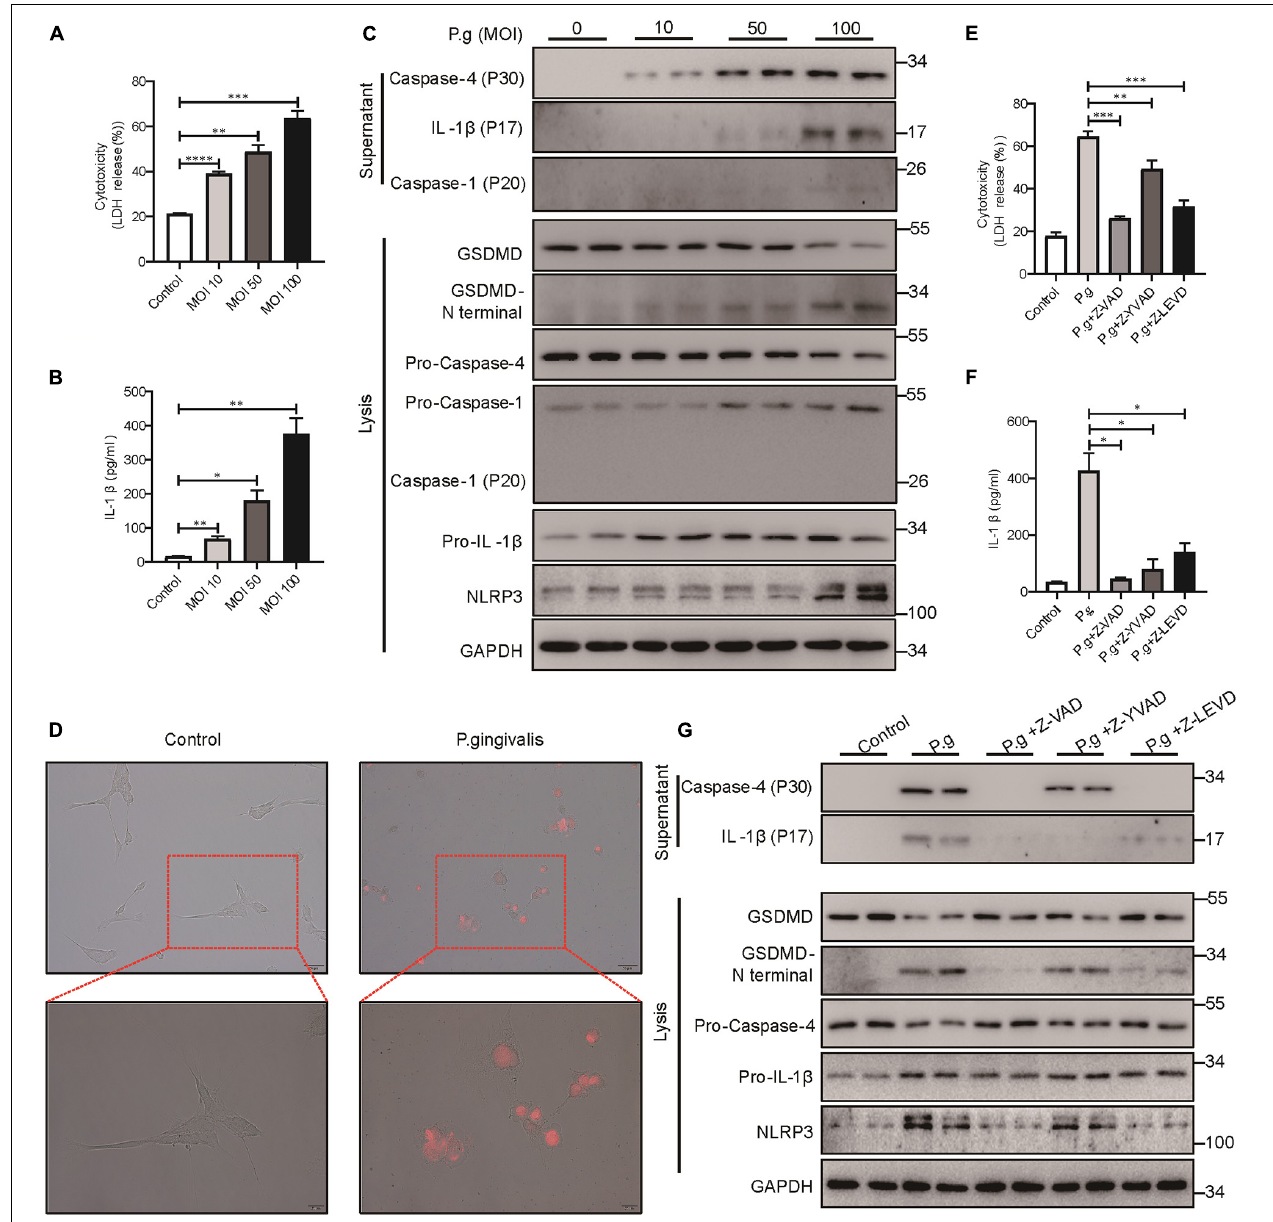
FIGURE 2 | P. gingivalis induced pyroptosis in PDLSCs dependent on caspase-4. (A–C) PDLSCs were infected with P. gingivalis (MOI, 10, 50, or 100) for 24 h. (A) The amount of cytoplasmic LDH released into the culture supernatant was measured by an LDH Cytotoxicity Assay Kit. (B) Cell culture supernatants were assayed for human IL-1 β by ELISA. (C) The IL-1 β , Caspase-4 and Caspase-1 secreted into the culture supernatants and the GSDMD cleavage, Pro-IL-1 β , Pro-Caspase-4, Pro-Caspase-1, NLRP3, and GAPDH in the cell lysates (lysis) were detected by immunoblotting. (D) The morphology of PDLSCs with P. gingivalis (MOI, 100) infection. Cells were stained with propidium iodide (PI, red) and analyzed under a microscope. (E–G) PDLSCs were pretreated with the pan-caspase inhibitor Z-VAD-FMK (20 µ M), the caspase-1 inhibitor Z-YVAD-FMK (20 µ M), or the capase-4 inhibitor Z-LEVD-FMK (20 µ M) for 1 h before P. gingivalis (MOI, 100) infection for 24 h. (E,F) Cell culture supernatant was collected and assayed for LDH release (E) and IL-1 β secretion (F) . (G) The IL-1 β and Caspase-4 secreted into the culture supernatants and the GSDMD cleavage, Pro-IL-1 β , Pro-Caspase-4, NLRP3, and GAPDH in the cell lysates (lysis) were detected by immunoblotting. The data are presented as the mean ± SEM. * P < 0.05, ** P < 0.01, *** P < 0.001, **** P <